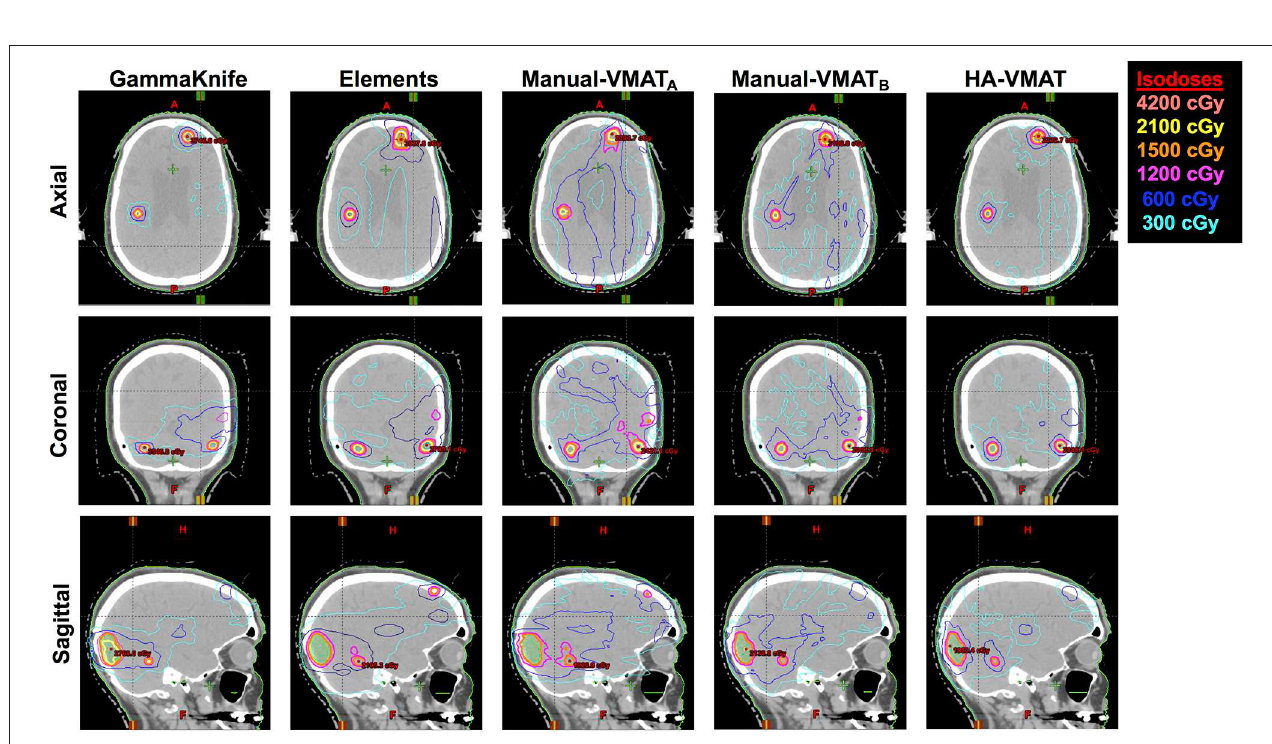
FIGURE 5 | Axial, coronal, and sagittal cuts of patient #15 selected to visually demonstrate differences in dose distribution among the five different SRS plans.